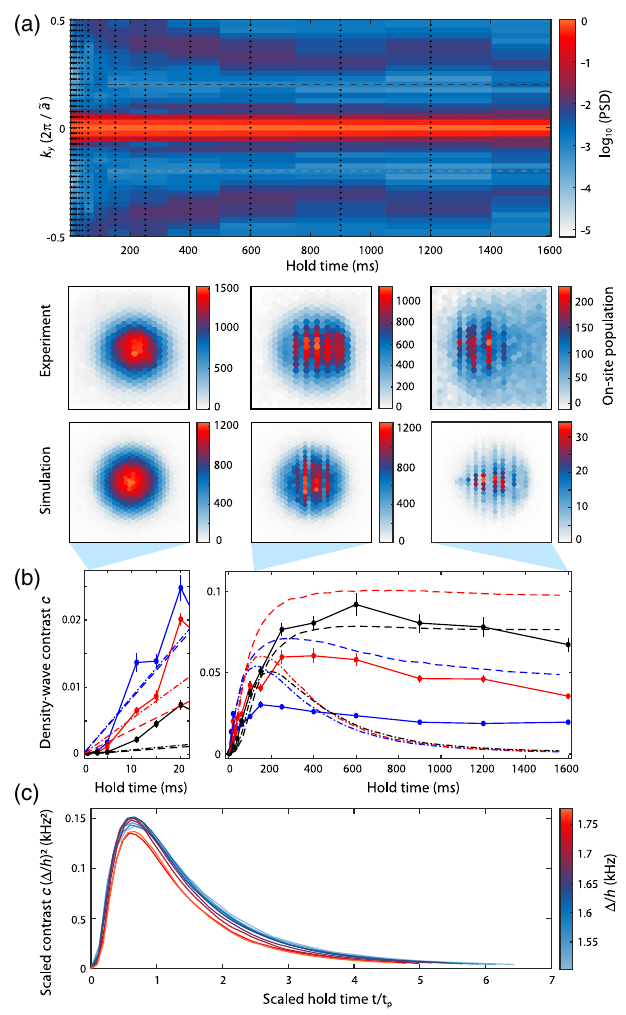
FIG. 3. Formation dynamics and decay of the density wave. (a)Thenormalizedpowerspectraldensityofthecolumnoccupations for a tilt with energy offset Δ ¼ h × 1 . 4 kHz initially develops a peak at k ˜ a= ð 2 π Þ ¼ (cid:2) 1 = 2 (period 2), which splits and moves to k ˜ a= ð 2 π Þ ∼ (cid:2) 1 = 3 (period 3) at longer time. The dots show the exact parameters for which data were taken. The dashed lines mark k ˜ a= ð 2 π Þ ¼ (cid:2) 1 = 5 , which is used in the computation of the density- wave contrast (see main text). (b) Dynamics of the density-wave contrast c fordifferentevolutiontimesafterthe quenchintothetilted system showing the fast buildup and slow decay of the patterns. The color encodes the tilt strength of Δ ¼ h × 1 . 1 kHz (blue), Δ ¼ h × 1 . 4 kHz(red), Δ ¼ h × 1 . 7 kHz(black).Theexperimentaldata (circles)arecomparedtoanumerical c -fieldsimulationincludingthe atomnumberloss(dashedlines)andwithoutloss(dash-dottedlines). The numerical simulation without atom loss shows a faster decay. T=J ¼ 100 .Theinsetsshow Thesimulationusesatemperatureof k B example single-shot density distributions from the experiment (top row, hold time is 1, 60, and 1600 ms) and the simulation with atom loss (bottom row, hold time is 0, 64, and 1560 ms). All error bars correspond to the 68% confidence interval. (c) The density-wave order of the simulated data without atom loss follows the scaling of theeffectiveHamiltonianandcollapsesonacurvewhenthetimeaxis andthedensity-waveorderis isrescaledbythepairtunnelingtime t p scaled by the energy offset squared Δ 2